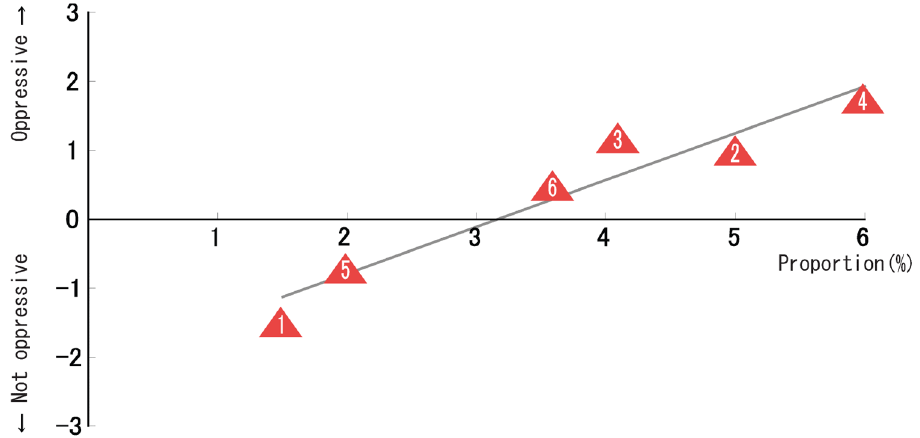
Figure 10. Correlation between proportion and oppressive feelings (rooftop advertising signs).